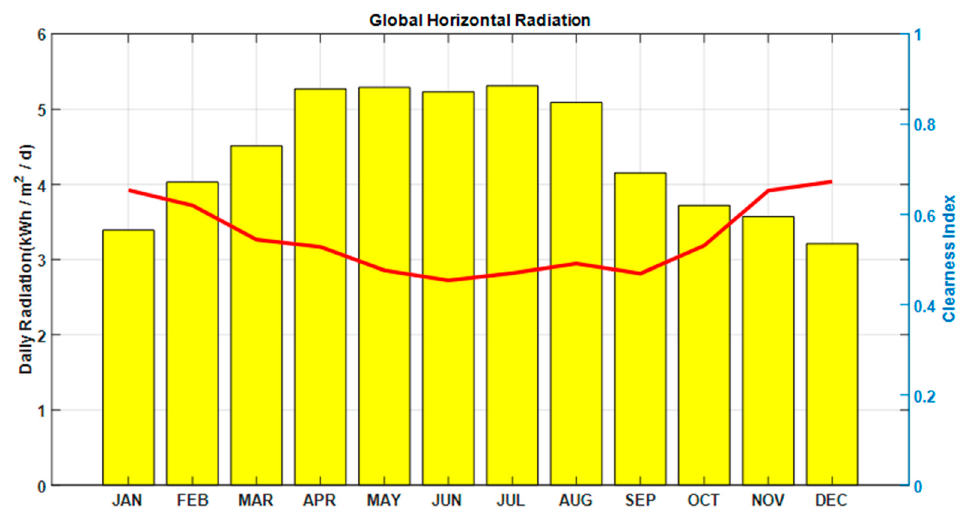
Figure 2. Monthly solar radiation intensity and clearness index in a year. The left vertical coordinate is the daily average solar radiation intensity, and unit is kWh/m 2 /day. The right vertical coordinate is the clearness index, between 0 and 1.